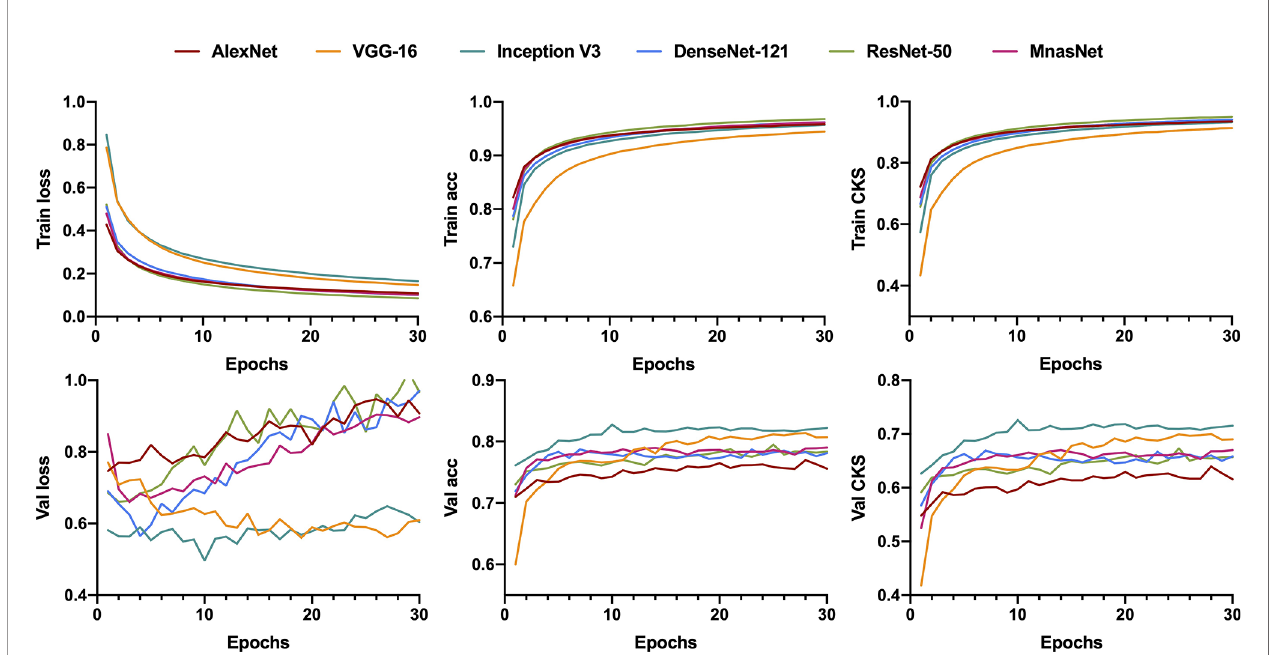
FIGURE 4 | Learning curves for patch-level ternary classi fi cation of six models showing the loss, accuracy, and the Cohen ’ s kappa score in training and validation. Train, training; Val, validation; acc, accuracy; CKS, the Cohen ’ s kappa